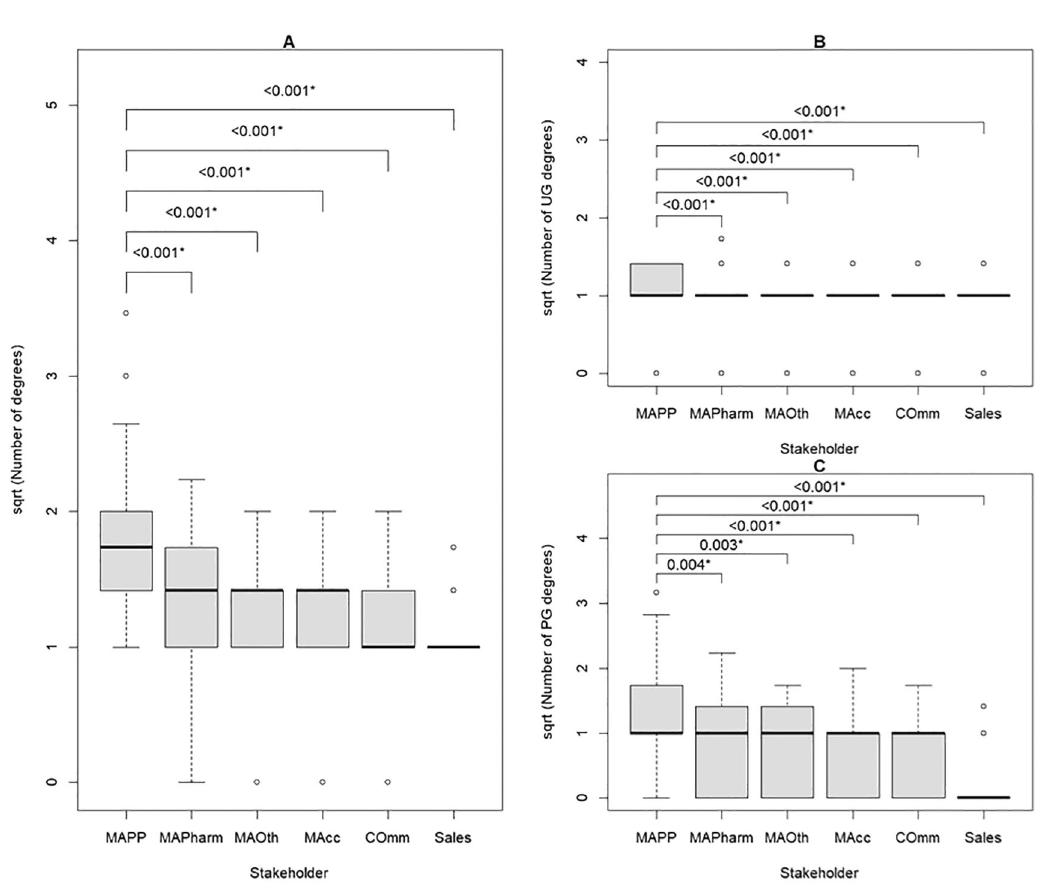
Figure 2. Number of degrees held by internal stakeholders in the pharmaceutical industry; number of degrees transformed using square root to overcome right skewness.